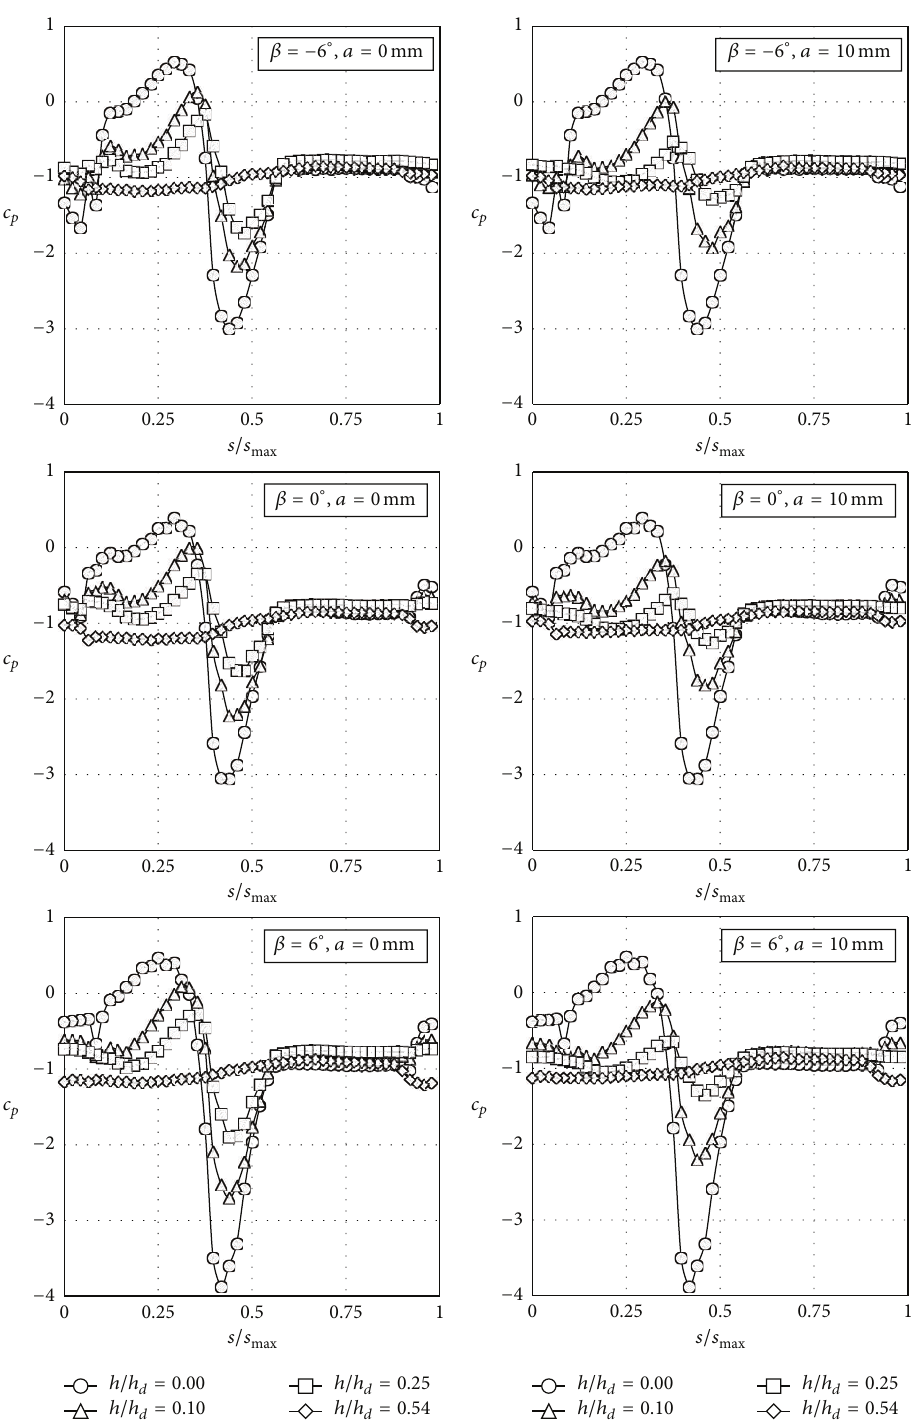
Figure 10: Pressure coefficient, 𝑐 𝑝 , distributions with the coach placed on the leeward railway track on an embankment with a slope 1:1, as a function of the nondimensional distance over the train surface at the middle cross-section, 𝑠/𝑠 max (see Figure 4(b)).